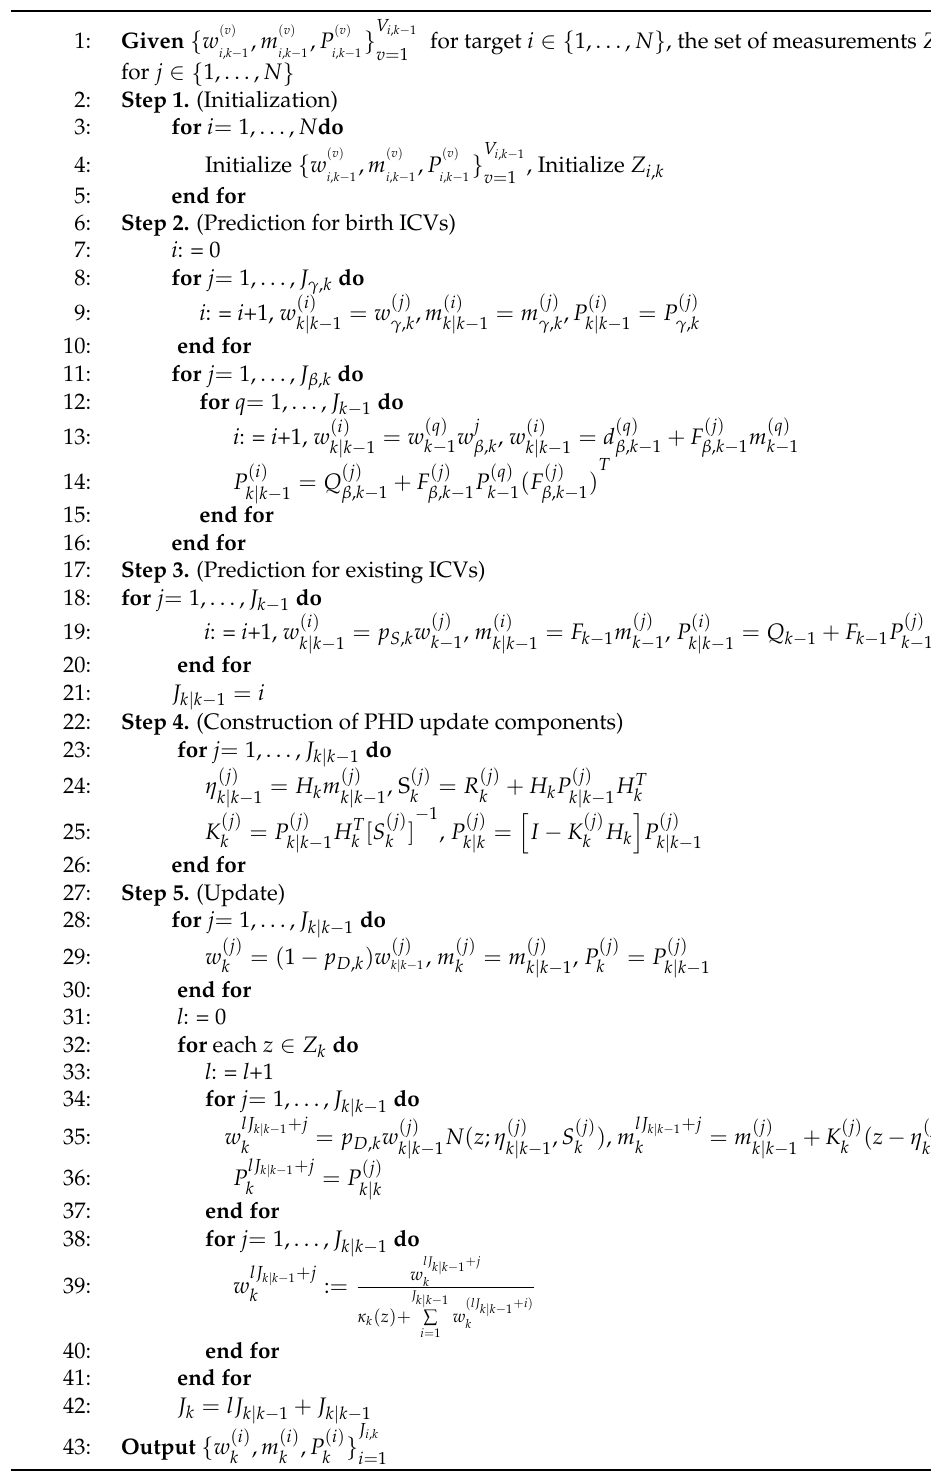
Table 1. Pseudocode for the